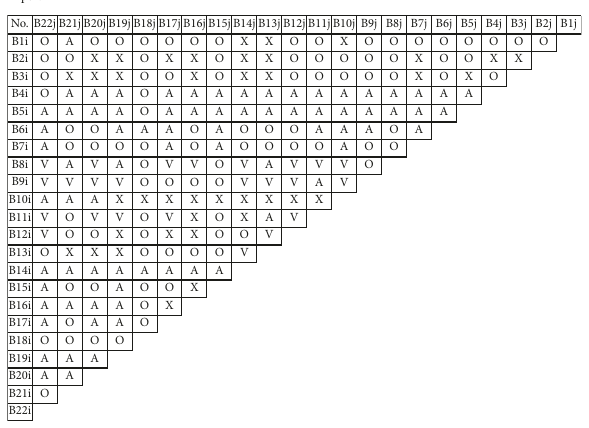
Table 5: ISSM from expert 2.